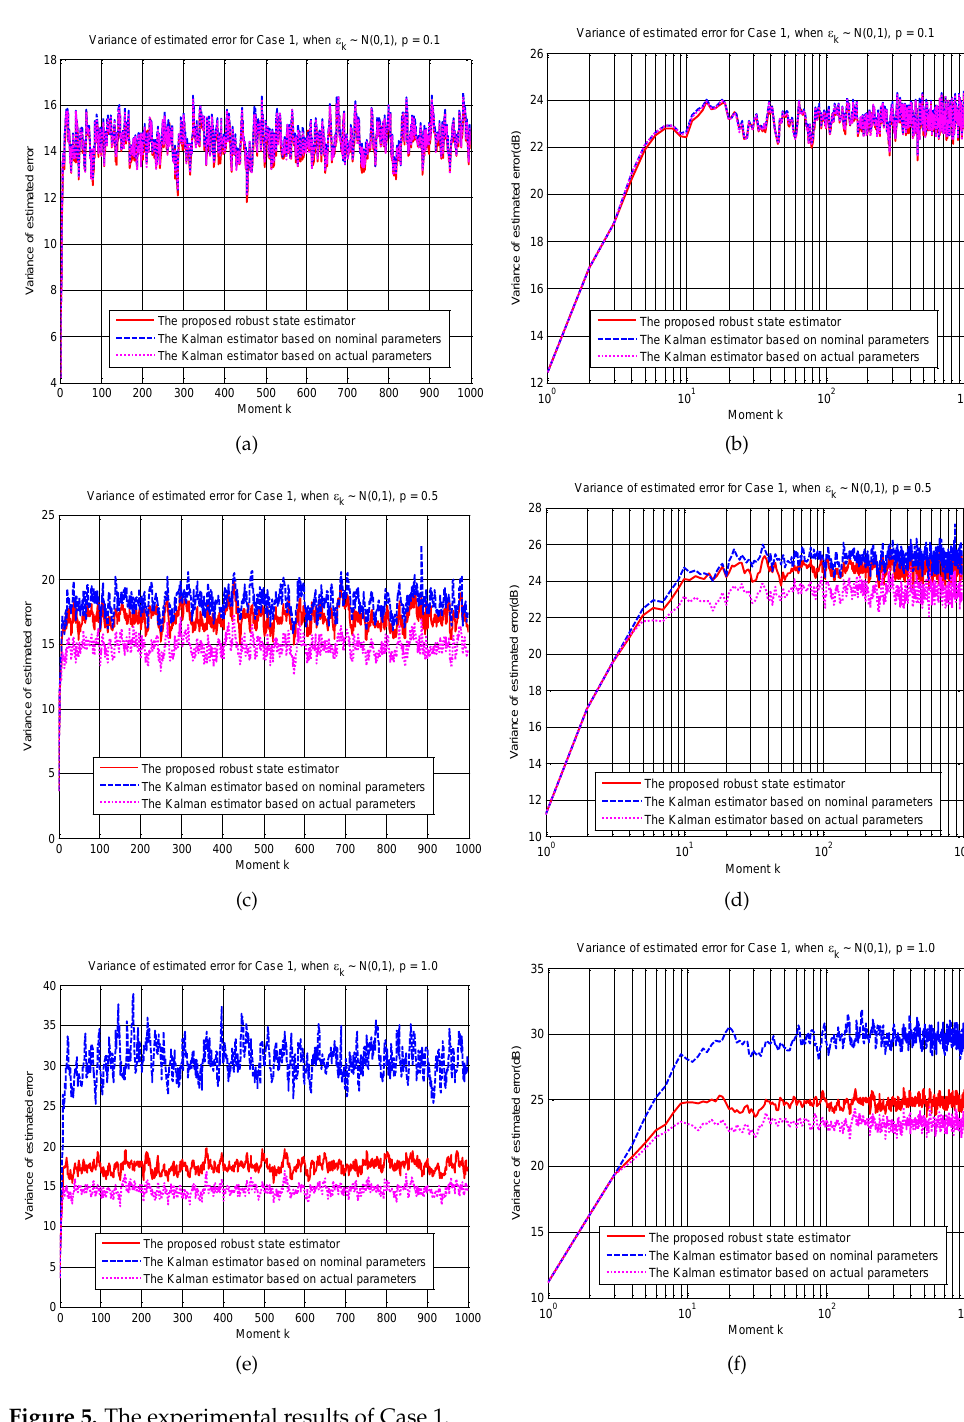
Figure 5. The experimental results of Case